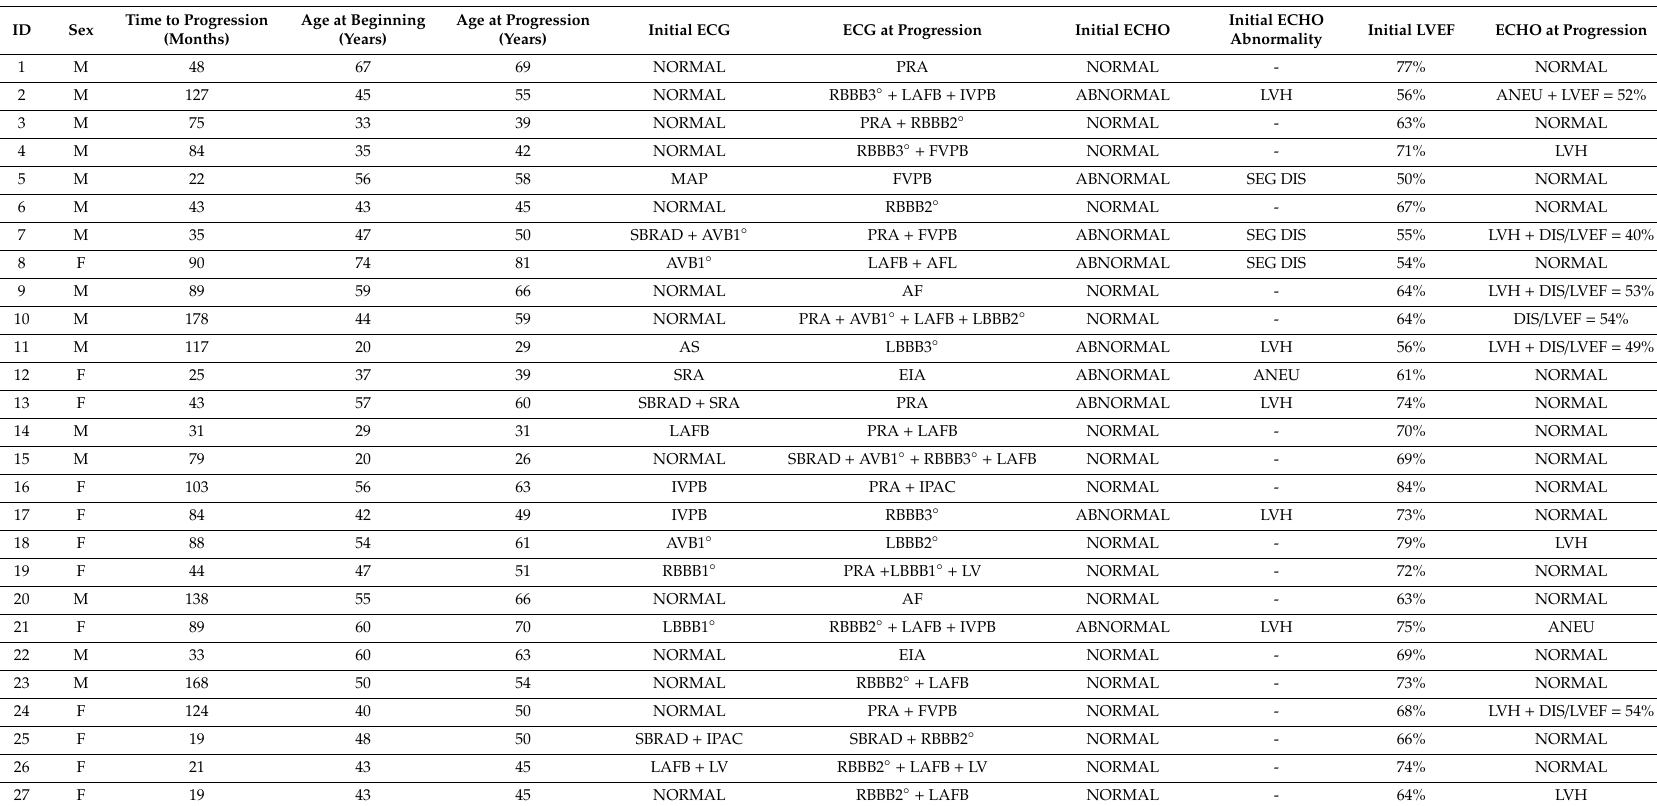
Table 2. Age, sex, follow-up time, and electrocardiogram (ECG) and echocardiogram (ECHO) abnormalities among those patients that progressed to the cardiac form (n = 37) AF: atrial fibrillation; AFL: atrial flutter; AS: sinus arrhythmia; AVB1 ◦ : first degree atrioventricular block; EIA: electrical inactive area; FPAC = frequent premature atrial complex; FVPB: frequent ventricular premature beats; IPAC-isolated premature atrial complex; IVPB: isolated ventricular premature beats; LAFB: left anterior fascicular block; LBBB1 ◦ : first-degree left bundle-branch block; LBBB2 ◦ : second-degree left bundle-branch block; LBBB3 ◦ : third degree left bundle-branch block; LV: QRS low voltage; MAP: migratory atrial pacemaker; PRA: primary ST-T wave changes; RBBB1 ◦ : first-degree right bundle-branch block; RBBB3 ◦ : third-degree right bundle-branch block; SBRAD: sinus bradycardia with heart rate 50 bpm; SRA: secondary ST-T wave changes; ANEU: aneurism; DIS; dysfunction; LVEF: left ventricular ejection fraction; LVH: left ventricular hypertrophy; SEG DIS: segmental